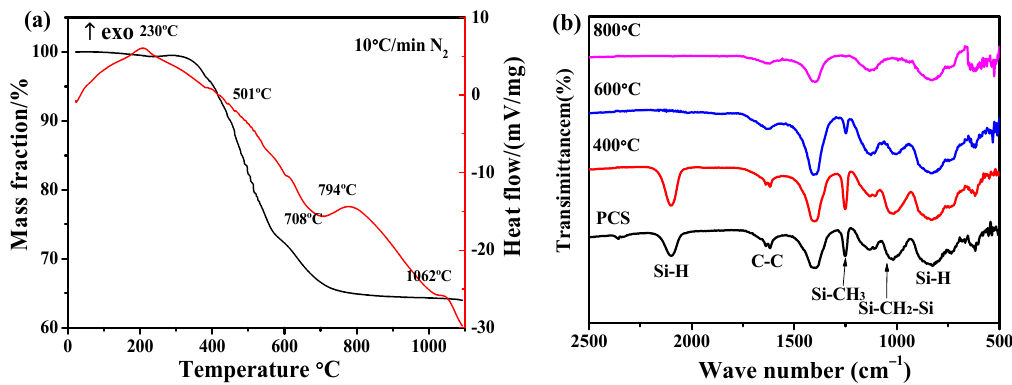
Figure 2. ( a ) TG-DSC curves of PCS, ( b ) FT-IR spectrums of PCS pyrolyzed at different temperatures. The characteristic absorption peaks of the functional group for PCS pyrolyzed at high temperature are indicated by the FT-IR spectra, as shown in Figure 2b. The two strong